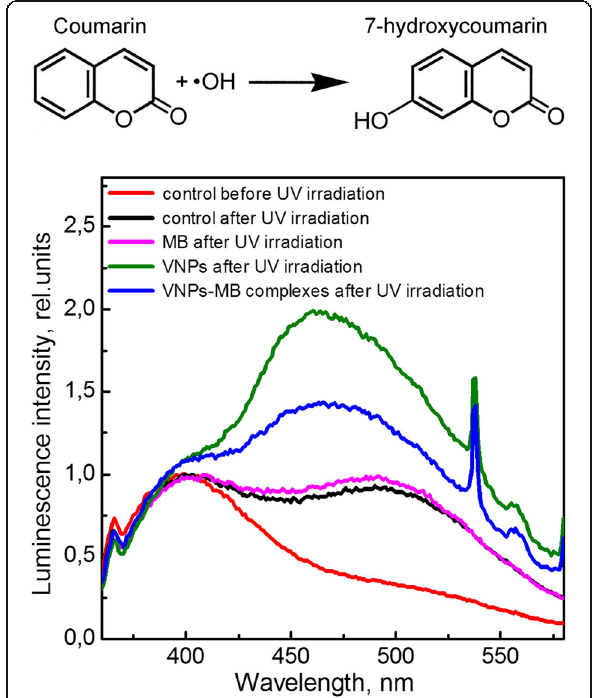
Fig. 3 Reaction of coumarin with hydroxyl radical to form fluorescent 7-hydroxycoumarin. Normalized fluorescence spectra of coumarin water solution, λ exc =325